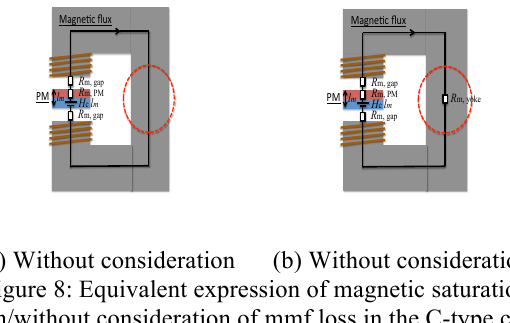
Figure 8: Equivalent expression of magnetic saturation with/without consideration of mmf loss in the C-type